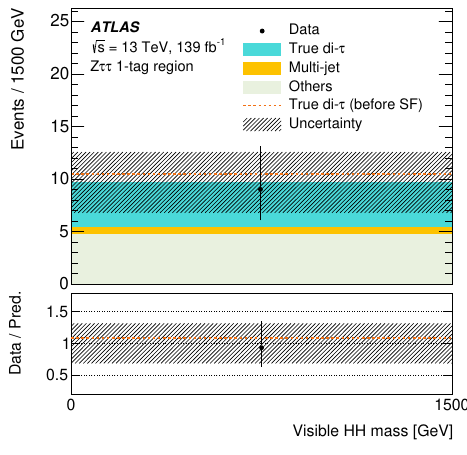
Figure 9. Predicted and measured event yields in the region labelled as ‘Z ττ 1-tag’ in table 2. All simulated events containing a generator-level τ + τ − pair matched to a simulated di- τ object are referred to as ‘True di- τ ’. The main contribution to the background referred to as ‘Others’ comes from the t ¯ t process (about 3.6 events). The lower panel shows the event yield ratio of the data and the predicted total background. The hatched bands represent combined statistical and systematic